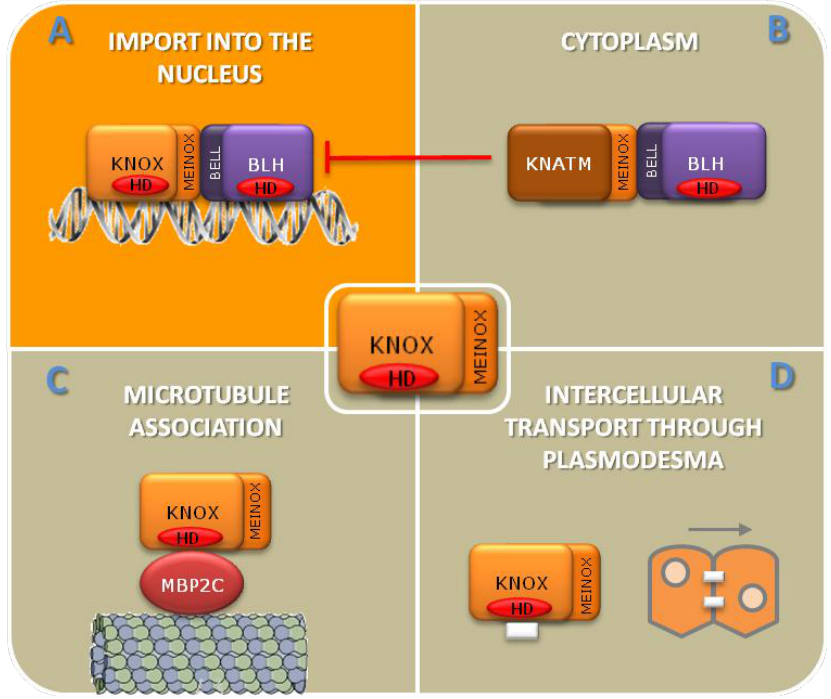
Figure 1. KNOTTED1-LIKE homeobox (KNOX) intracellular localization is regulated by protein-protein interactions. KNOX/BLH interaction through the MEINOX and BELL domains, respectively, targets the complex to the nucleus ( A ). KNATM interacts with some BEL1-like homeobox (BLHs) through its MEINOX domain and interferes with KNOX/BLH complex formation and nuclear import ( B ). Interaction with the microtubule-associated protein MBP2C targets KNOX to the plasma membrane ( C ) [32]. Some KNOXs are able to move from cell to cell through plasmodesmata ( D )